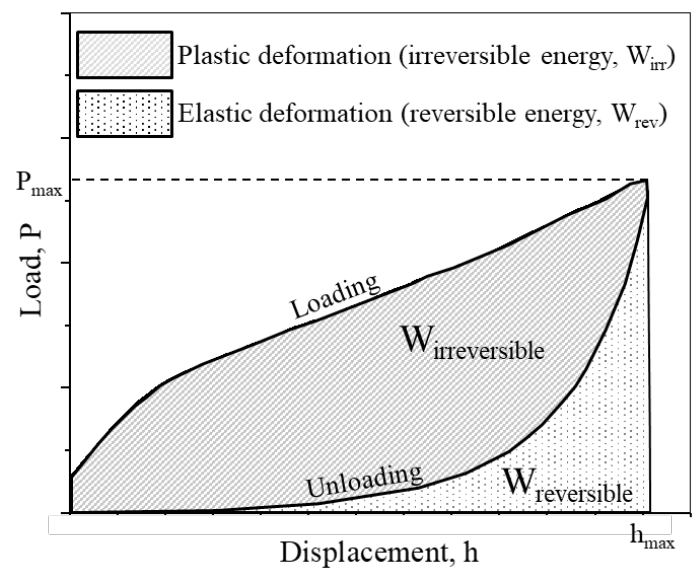
Figure 4. Determination of plastic and elastic work in the instrumented indentation testing. All results are presented as a boxplot, which is explained in Figure